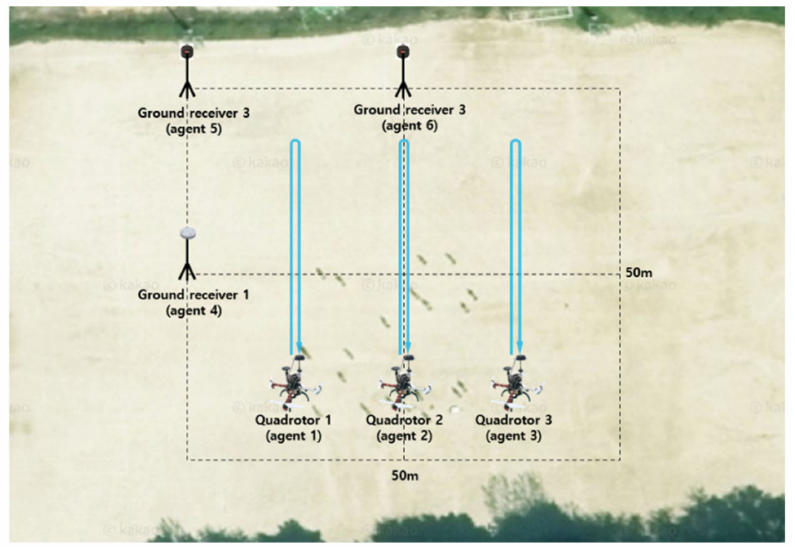
Figure 15. Three quadrotors and GNSS receivers on ground during tests at Hongik University, Seoul, South Korea.